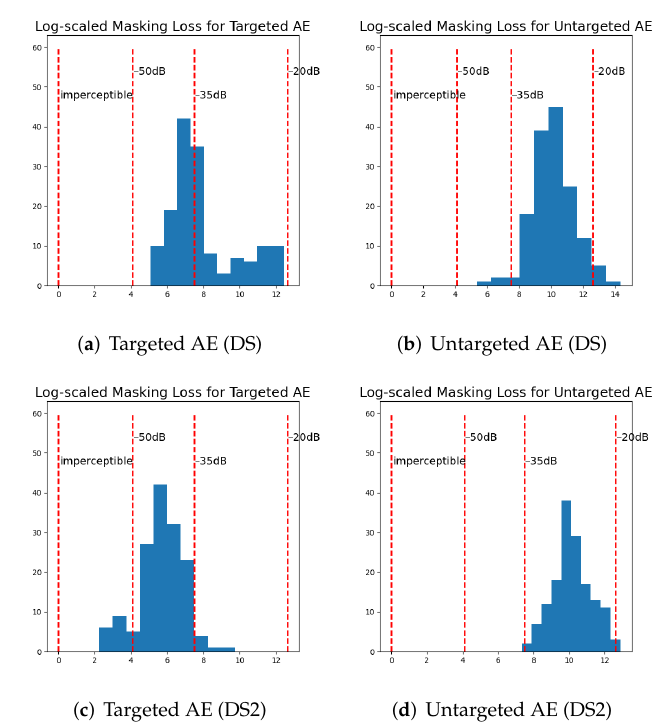
Figure 1. Histograms comparing the masking loss ( l θ () in Equation (5)) of our generated adver- sarial examples (AEs) for DeepSpeech (DS) and DeepSpeech2 (DS2) with the − 20 dB distortion, − 35 dB distortion, and − 50 dB distortion sets published by [9] (labeled as − 20 dB, − 35 dB, and − 50 dB, respectively) and the first set of imperceptible adversarial examples published by [36] (la- beled as imperceptible). The smaller the masking loss, the lower the resulting distortion perturbations. Coordinates along the horizontal axis were calculated as ln ( masking loss + 1 ) . Overall, the masking loss of targeted AEs against DeepSpeech2 was smaller compared with DeepSpeech. The masking loss of most untargeted AEs was between − 20 dB and − 35 dB.